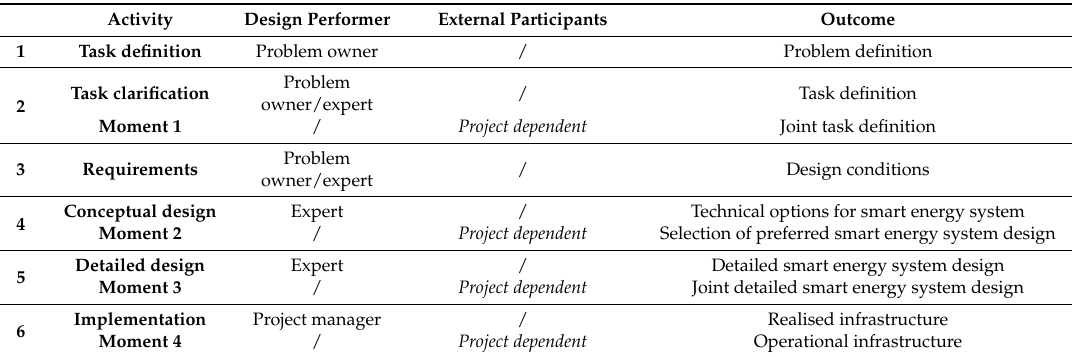
Table 2. Decision-making phases with design performers and external